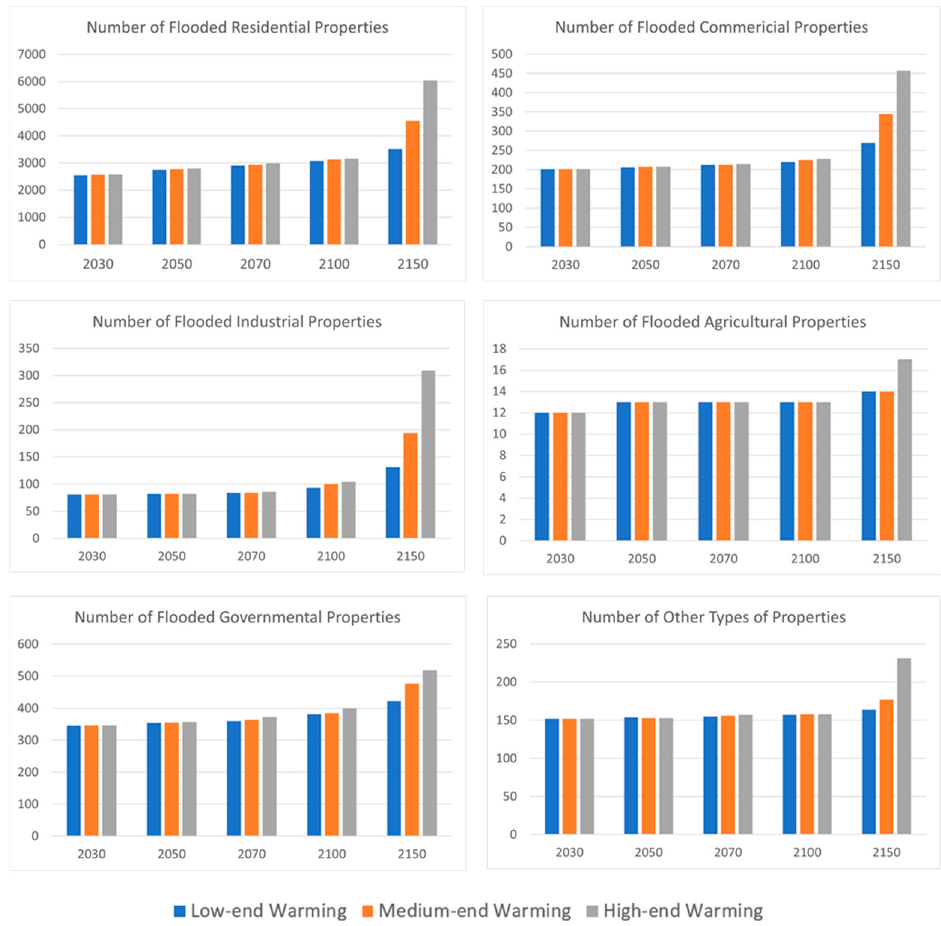
Figure 4. Number of flooded properties for different categories, where x-axis denotes the year and y-axis denotes the number of properties for the specific category.